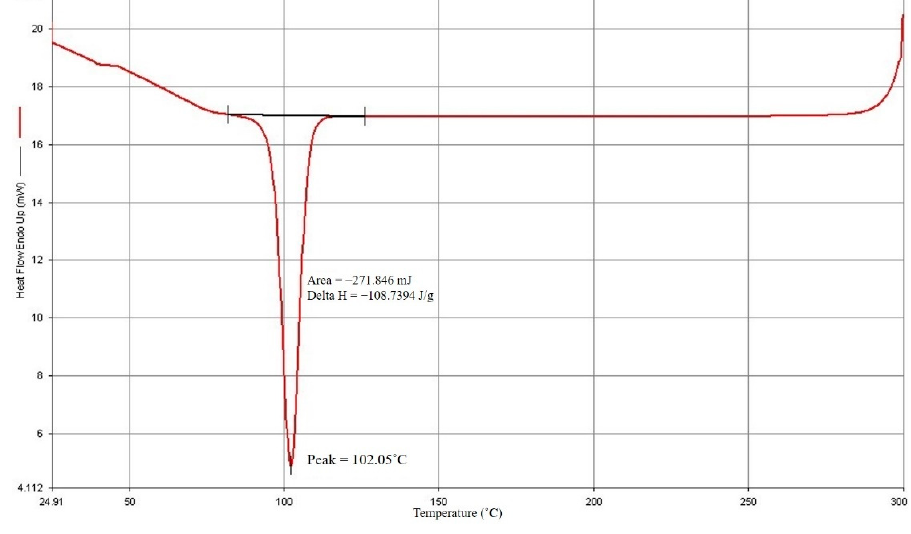
Figure 3. PP crystallization point.